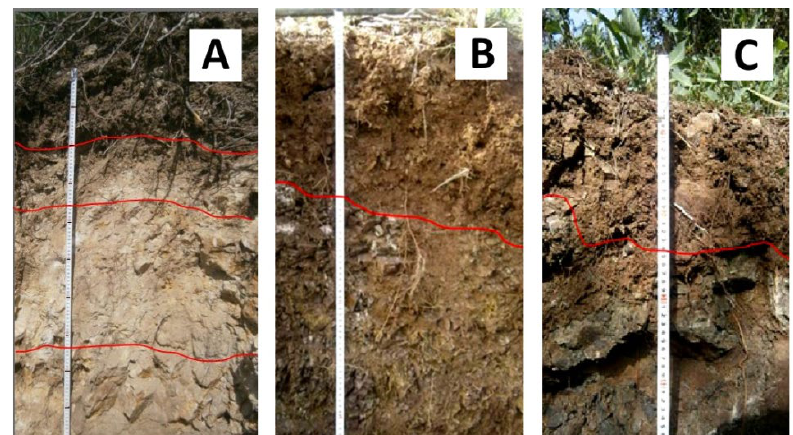
Figure 1. Representative soil profiles from the studied area land, (B) rangeland, and (C) forest land. The red lines represent borders between soil horizons in each